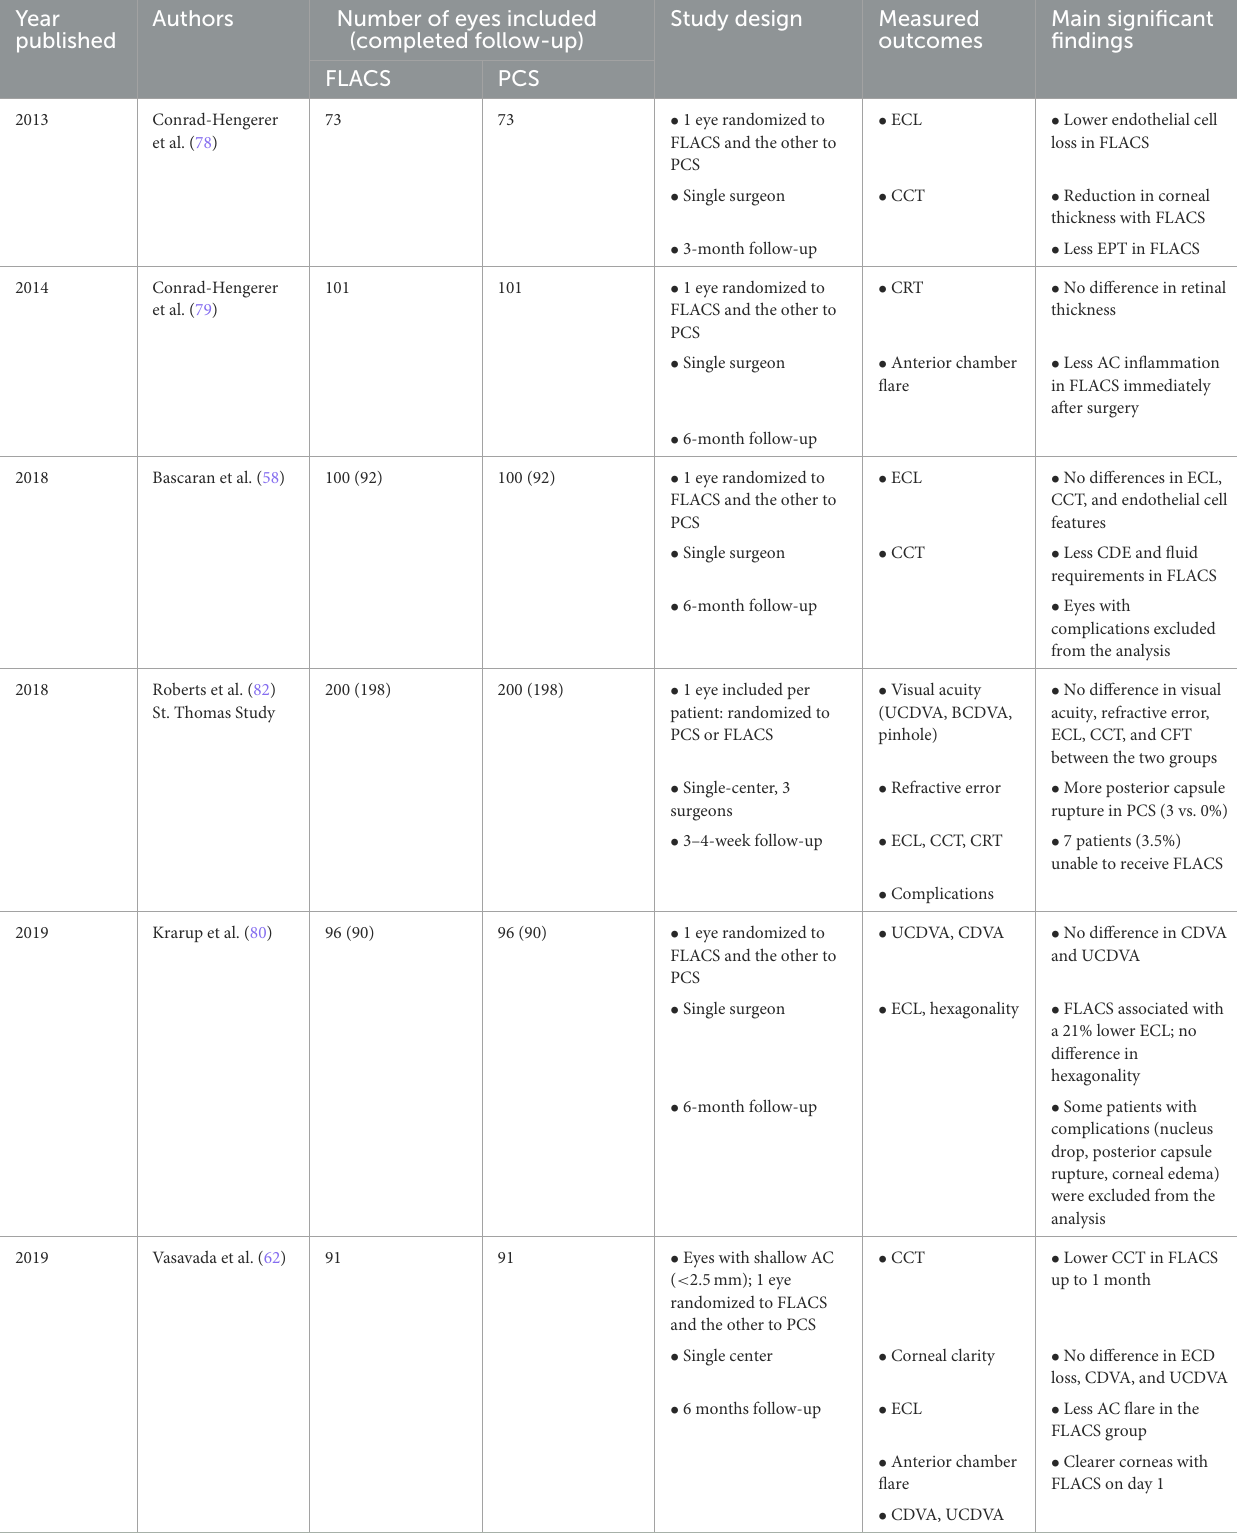
TABLE 1 Summary of the main randomized clinical trials comparing phacoemulsification cataract surgery (PCS) and femtosecond laser-assisted cataract surgery (FLACS). Year